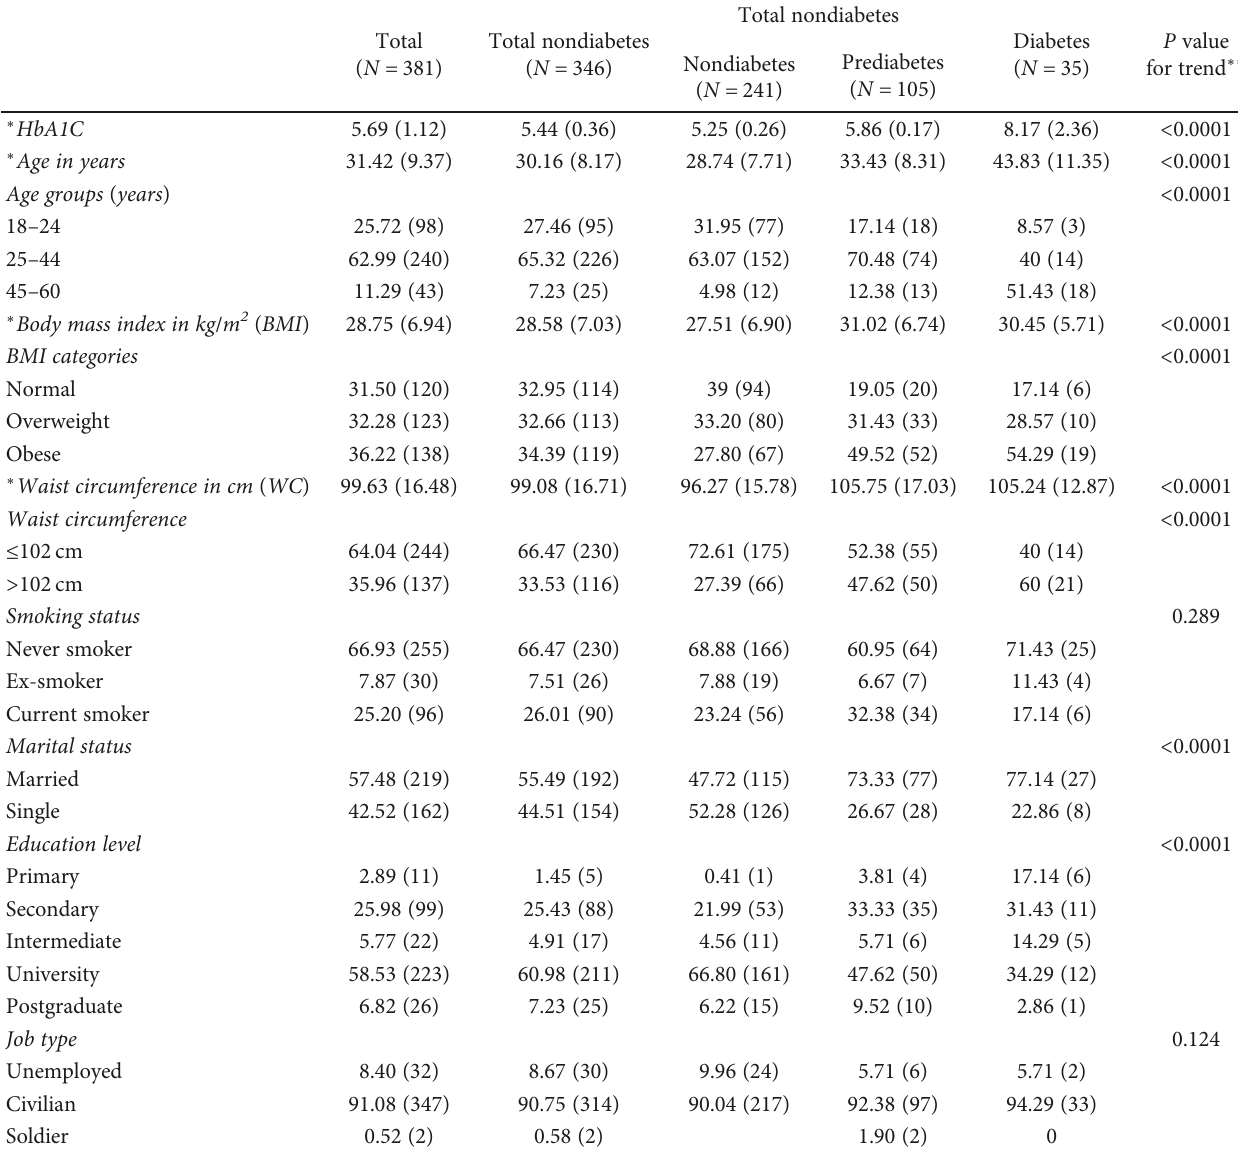
Table 1: General characteristics of participants by diabetic classi fi cation in male Al-Kharj study